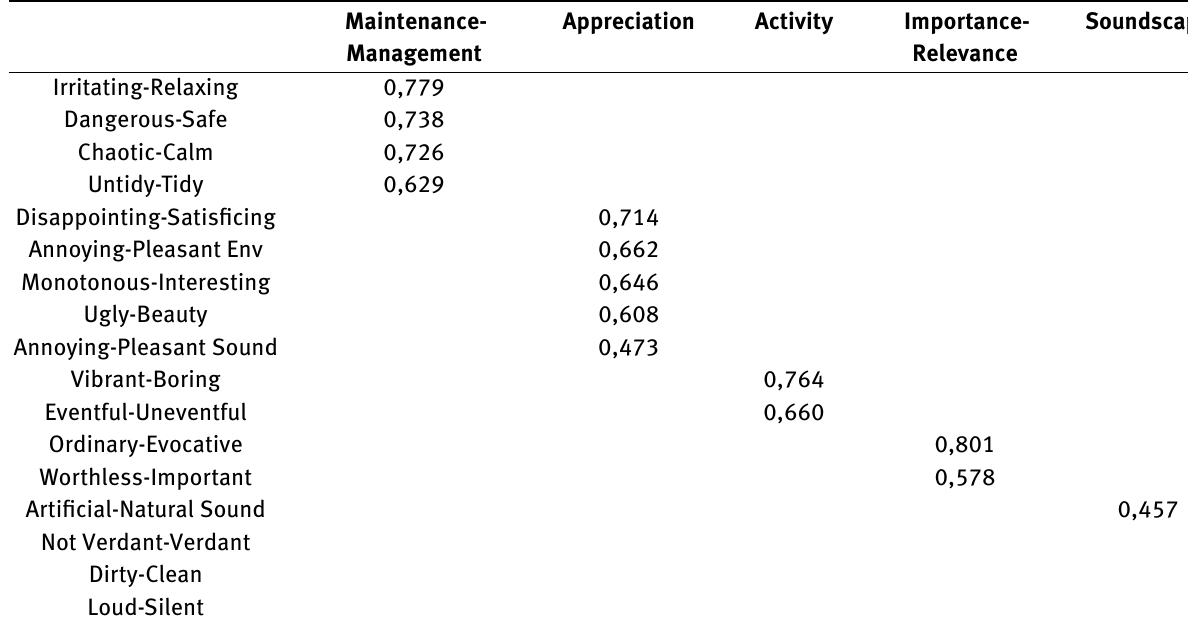
Table 4: Rotated component matrix of the Principal Component model